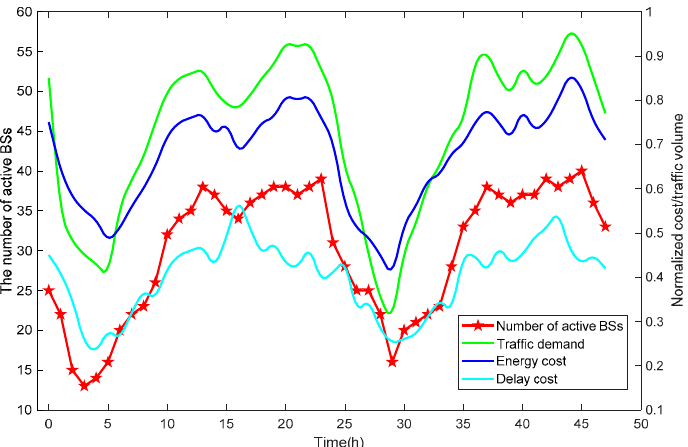
Figure 12. Network Performance of SSC-UA Scheme.